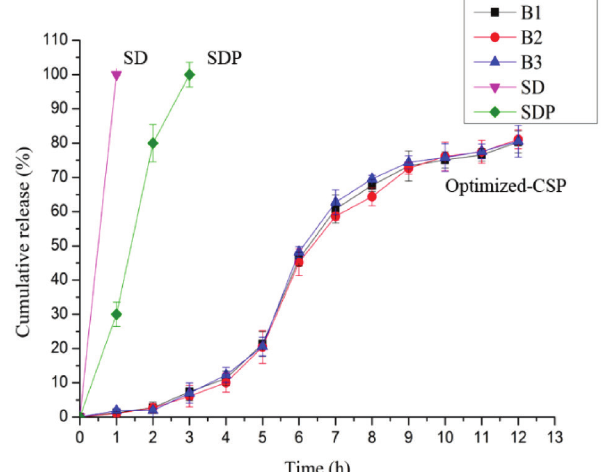
FIGURE 3 - The cumulative release of tacrolimus-SD, tacrolimus-SDP and tacrolimus-CSP of optimized formulations. Data are presented as mean ± SD (n = 3). Batch numbers of tacrolimus-CSP: (  ) B1, (  ) B2, (  )